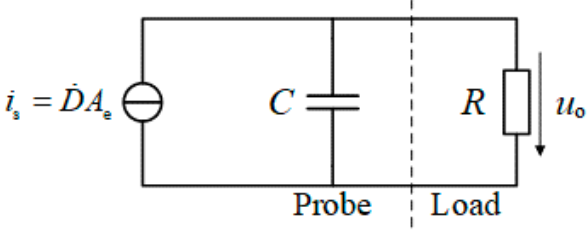
Figure 1. Norton Equivalent circuit of D-dot sensor. Where D refers to the electric flux density of the measured electric field; C refers to the equivalent capacitance of the D-dot sensor; R refers to the characteristic impedance of the transmission line; u 0 refers to the output voltage of the D-dot sensor; A e refers to the equivalent area of probe antenna. Figure 2. Amplitude–frequency response curve of D-dot sensor.